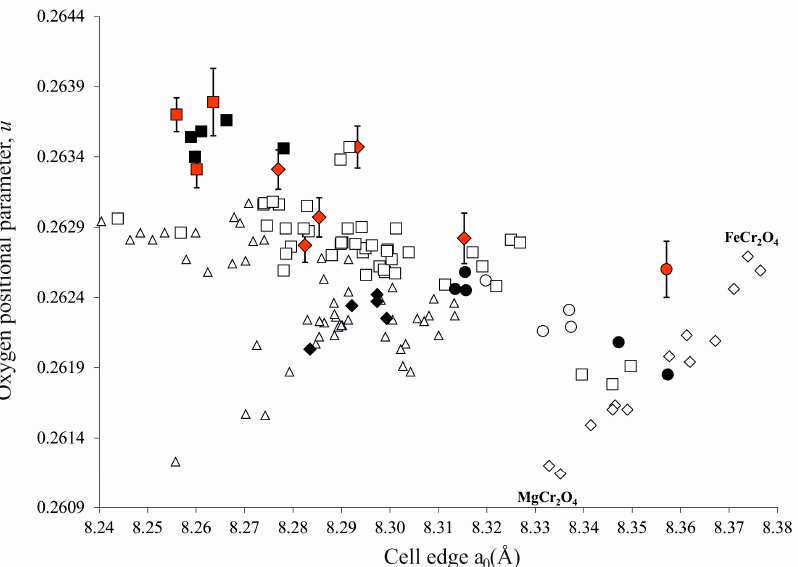
Figure 3. Oxygen positional parameter, u , vs cell edge, a 0 . Red squares, diamonds and circle represent Amsaga Cr-spinels in amphibole, chlorite and talc–serpentine matrix, respectively; open circles represent komatiites from Nuggihalli Cr-spinels [21]; open squares represent Bushveld, Rum and Stillwater Cr-spinels [22–24]; open triangles represent ophiolites [14,16–18]; open diamonds represent MgCr 2 O 4 -FeCr 2 O 4 synthetic spinels [52]; full squares, diamonds and circles represent Cr-spinels from Archean complexes of Fiskenaesset, Zimbabwe and Ujaragssuit [31].